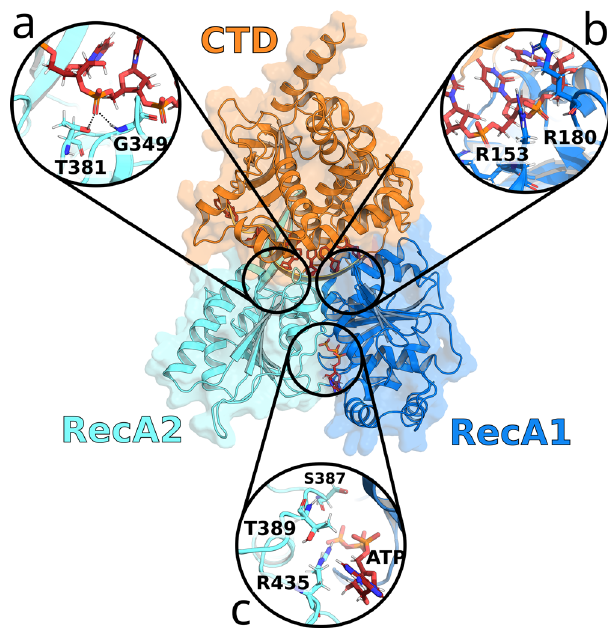
Fig. 1 Prp43 in the closed state (PDB ID: 5LTA). C-terminal domain (CTD, orange), RecA2 domain (cyan) and RecA1 domain (blue). Boxes show close-up views on the hook-loop ( a ), the hook-turn ( b ), and on the ATP- pocket ( c